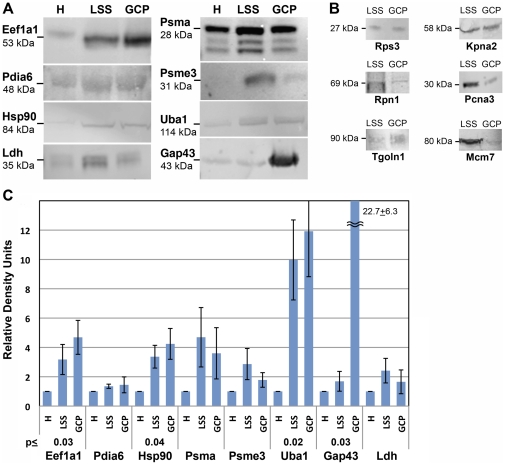
Abundance of non-typifying proteins in fetal brain fractions including GCPs, as determined by Western blot.
A shows the relative abundance in fetal brain homogenate (H), low-speed supernatant (LSS) and GCPs (40 µg protein/lane) of six non-typifying proteins, a cytosolic marker (Ldh) and a growth cone marker (Gap43). Hsp90 is Hsp90ab1. B illustrates the presence of immunoreactivity of six additional proteins in fetal brain LSS and GCPs (equal amounts of protein loaded). C shows the quantitative analysis of the data in A. Net fluorescence intensities of the bands shown in A were normalized to H for each experiment and then averaged (experiments done in triplicate). The resulting relative density units shown equal the fold increase in immunoreactivity relative to H (means ± s.e.m.). p values are shown where GCP enrichment over H was significant.